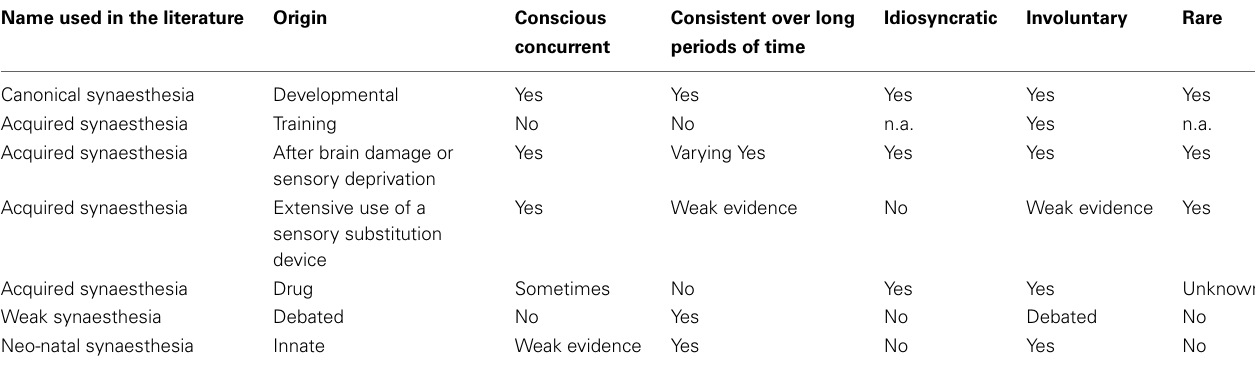
Table 2 | Illustration of the various kinds of phenomena that have been labeled as synaesthetic in the literature—and how they depart from the characteristics of developmental/canonical